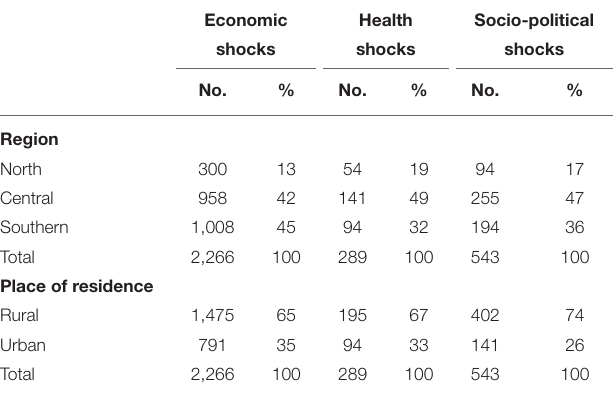
TABLE 3 | Distribution of shocks.